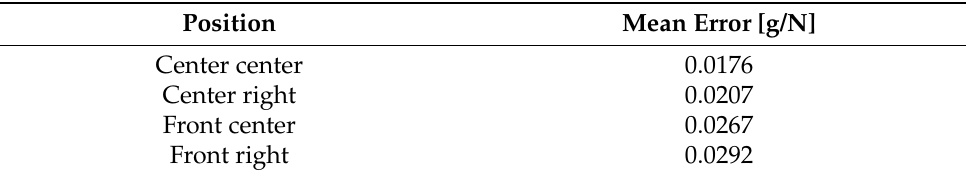
Table 4. Mean modulus of the error in the frequency range (150–300 Hz) between the model fit and the experimental data (Figure